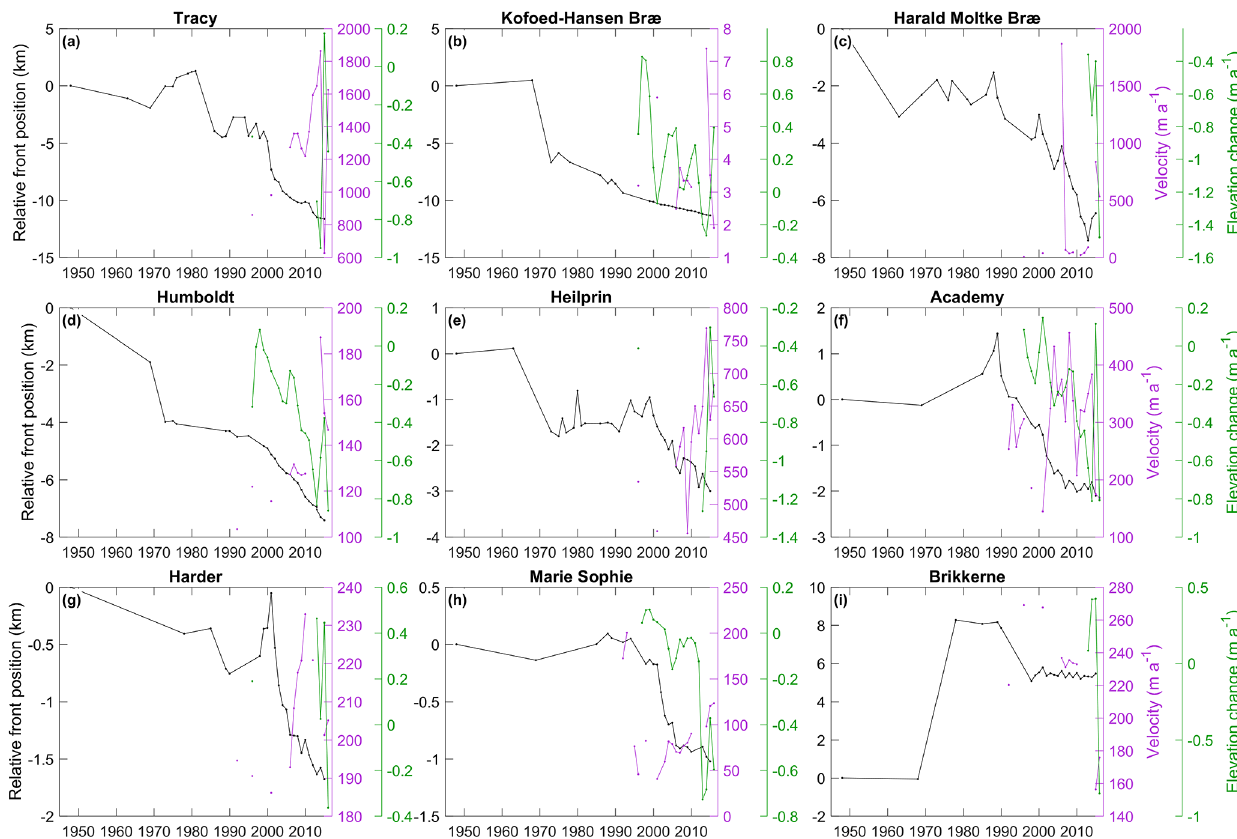
Figure 6. Front position and velocity and elevation change at nine outlet glaciers grounded at their terminus in northern Greenland. Left axes show relative front position (black line) between 1948 and 2015 relative to their initial position in 1948; right axes show grounding-line velocities (purple) between 1996 and 2015. Surface elevation changes averaged across the glacier centre line profile (green) for 1996 to 2015.